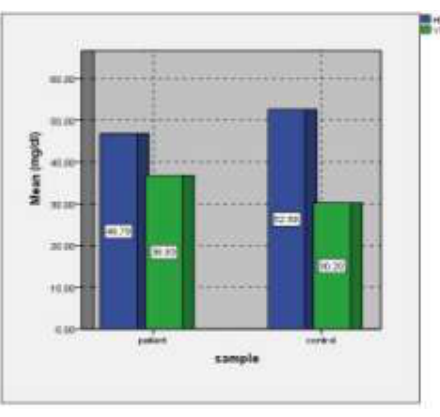
Figure 1: Mean serum total cholesterol (cholesterol), triglyceride (TG) and low density lipoprotein (LDL) in patients with cholelithiasis and healthy controls (milligram per deciliter).